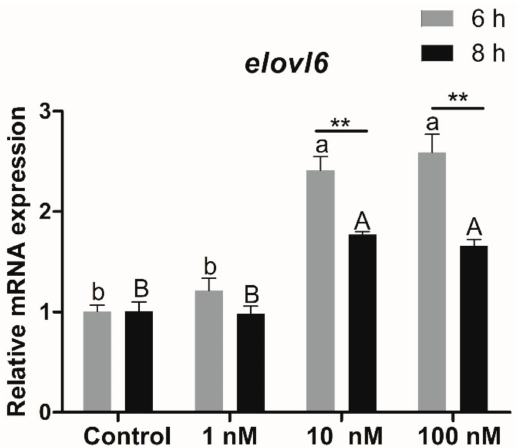
Figure 6. The transcriptional expression of elovl6 in hepatocytes of rainbow trout treated with graded amounts of insulin. Control group was selected as normalization. Data were presented as means ± S.E.M. (n = 3). Capital letters show the di ff erences in the 8 h group. Lowercase letters show the di ff erences in the 6 h group. Means that share the same superscript letter are not significantly di ff erent ( p > 0.05). ** p <